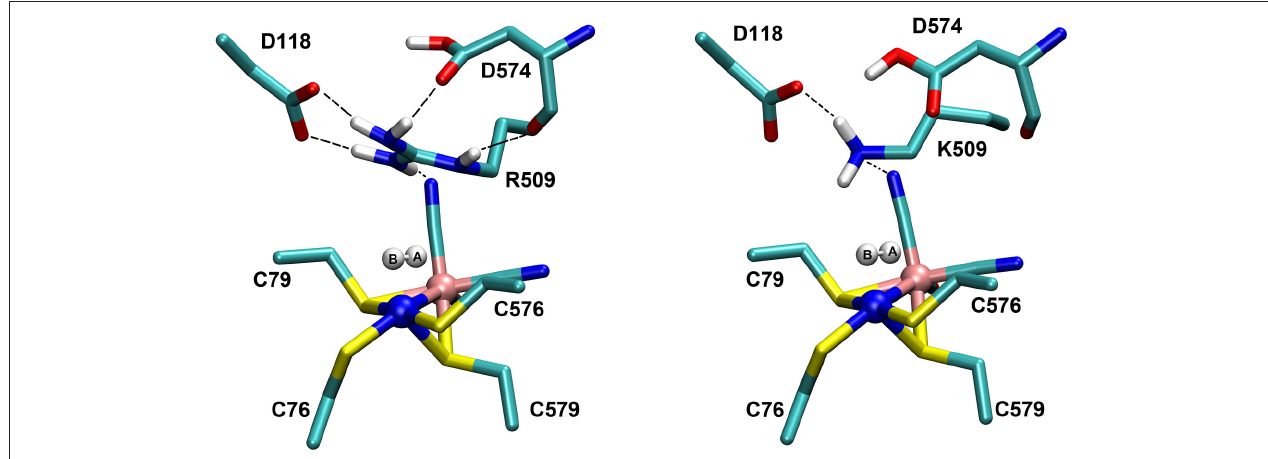
FIGURE 5 | Details of the substrate H 2 binding in the Ni-SIa state of the catalytic site of the [NiFe]-hydrogenase. (Left) : In the wildtype E. coli Hyd-1, the arginine residue 509 makes strong hydrogen bonding interactions with the aspartates 118 and 574. (Right) : In the R509K mutant, explicit hydrogen bond formation is not given and the electrostatic interactions with the aspartate residues are less